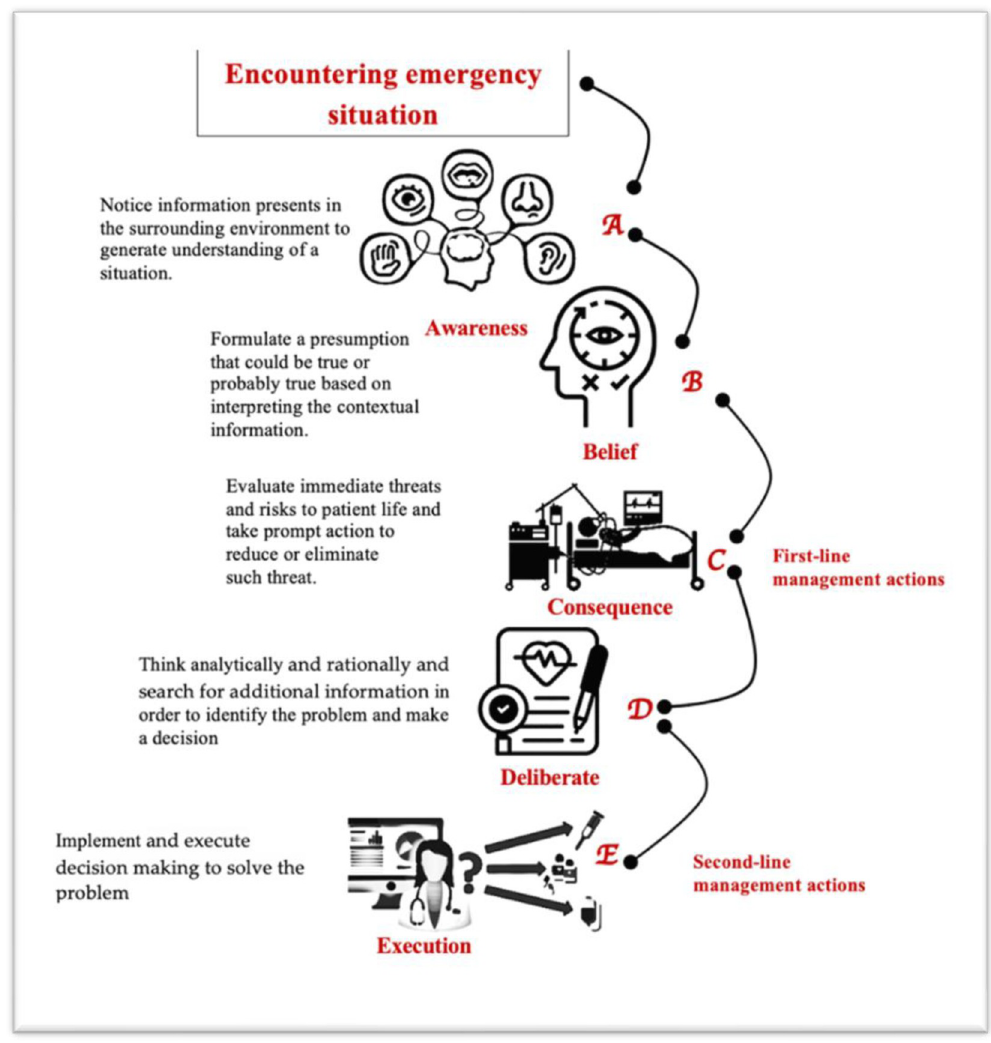
Fig 2. A proposed theoretical